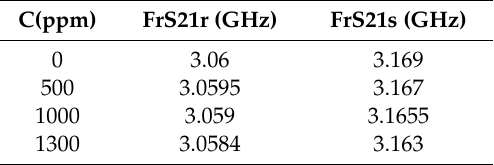
Table 3. Frequency shift versus ethanol concentration.